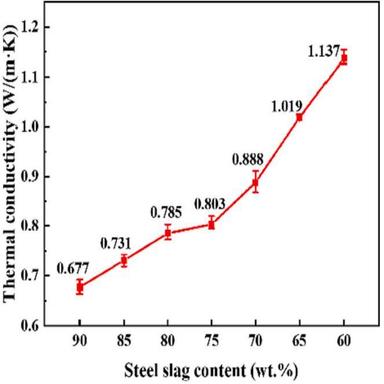
Thermal conductivity of samples after sintering at 1200 ◦C with different pretreated steel slag contents.